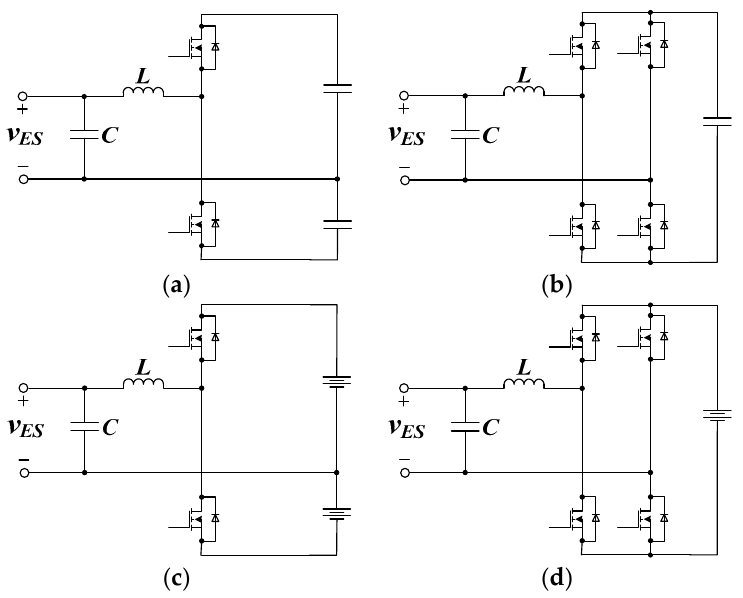
Figure 3. Typical topologies of ES-1 and ES-2. ( a ) ES-1 realized by half-bridge VSI; ( b ) ES-1 realized by full-bridge VSI; ( c ) ES-2 realized by half-bridge VSI; ( d ) ES-2 realized by full-bridge VSI.